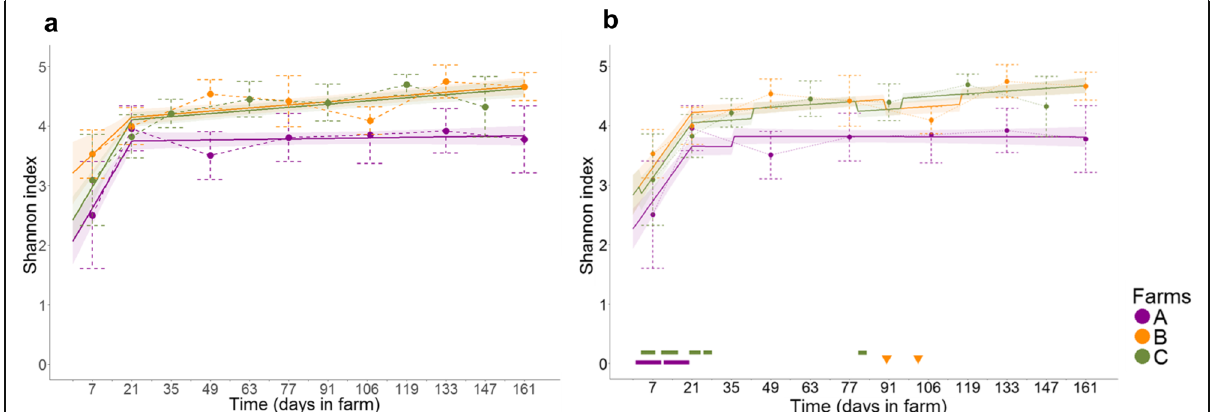
Fig. 6 Dynamics of the mean observed and predicted Shannon index for each farm. The predicted dynamics of the Shannon index, without and with the antibiotic-treatment effect, in the final model are shown in panels ( a ) and ( b ), respectively. The mean values ± standard deviations of the observed data for each farm are represented by the dashed bars. Model-predicted profiles and their 95% confidence bands are represented by the solid lines and bands, respectively. Antibiotic treatments during sampling or within 15 days before sampling are colored coded by farm and indicated above the x-axis in panel ( b